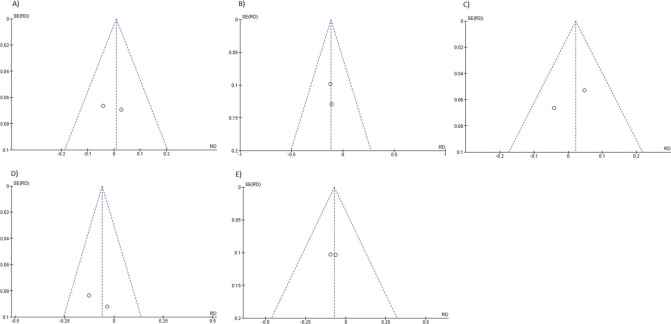
Funnel plots for comparison FK506 plus MMF vs. CyA plus MMF. A) Graft loss; B) Acute rejection; C) Mortality; D) Infection; E) Adverse events. Fixed effect model was used for A, B, C, and D.